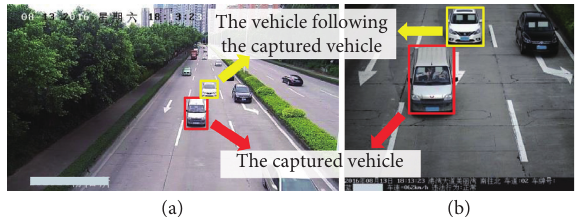
Figure 15: A captured vehicle image pair and the captured vehicle: (a) the key frame in RVS video; (b) the VIC image.